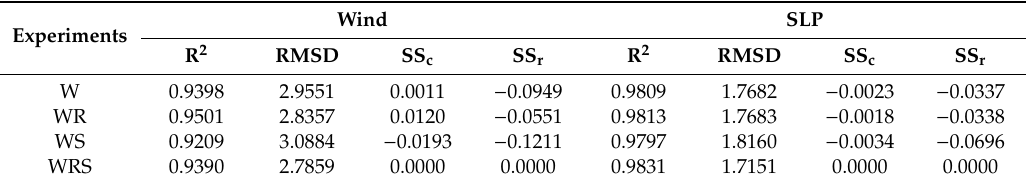
Table 3. Correlation coe ffi cient (R 2 ), root-mean-square di ff erence (RMSD) and skill score (SS c and SS r ) for 10-m wind and SLP from the di ff erent experiments.